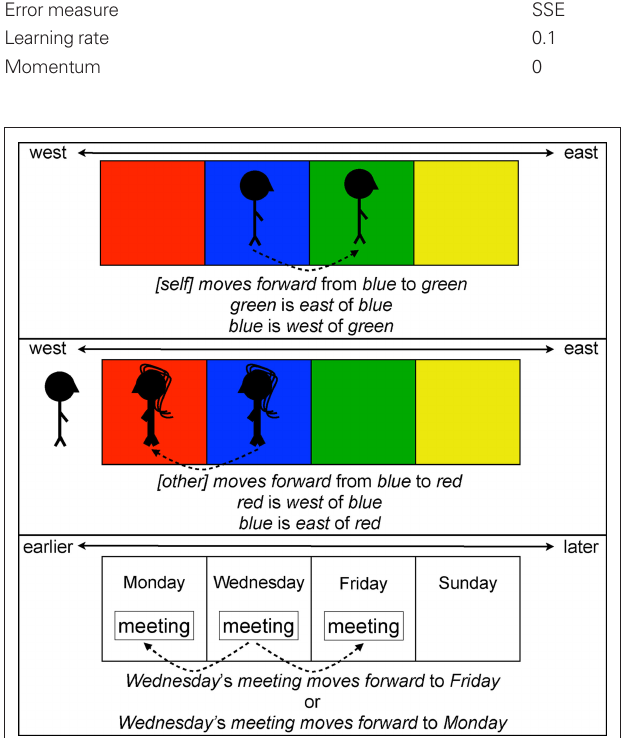
Figure 2 | a diagram illustrating the structure of spatial and temporal relations in the model environment. The network learns about the consequences of both itself and other agents moving in the environment, though movement in the temporal domain is